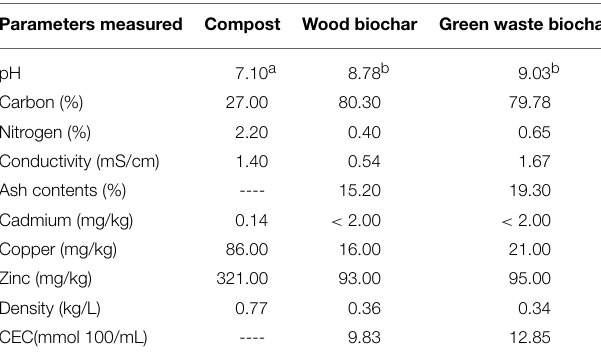
TABLE 1 | Physicochemical parameters of compost, wood biochar and green waste biochar. Parameters measured Compost Wood biochar Green waste